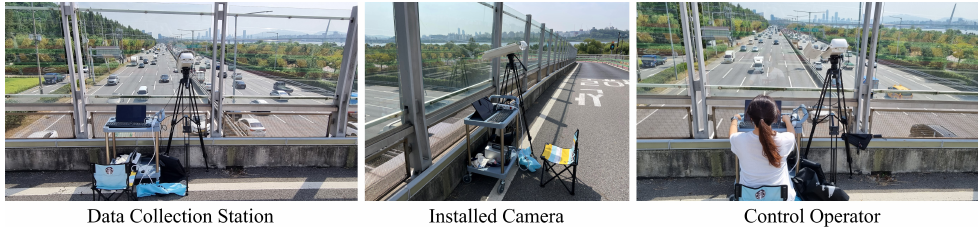
Figure 3. Data collection settings. Vehicles and LPs are captured using a camera fixed on a highway overpass with a residing operator controlling the data collection